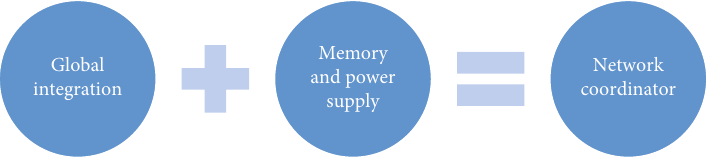
Figure 3: Functions of network coordinator.